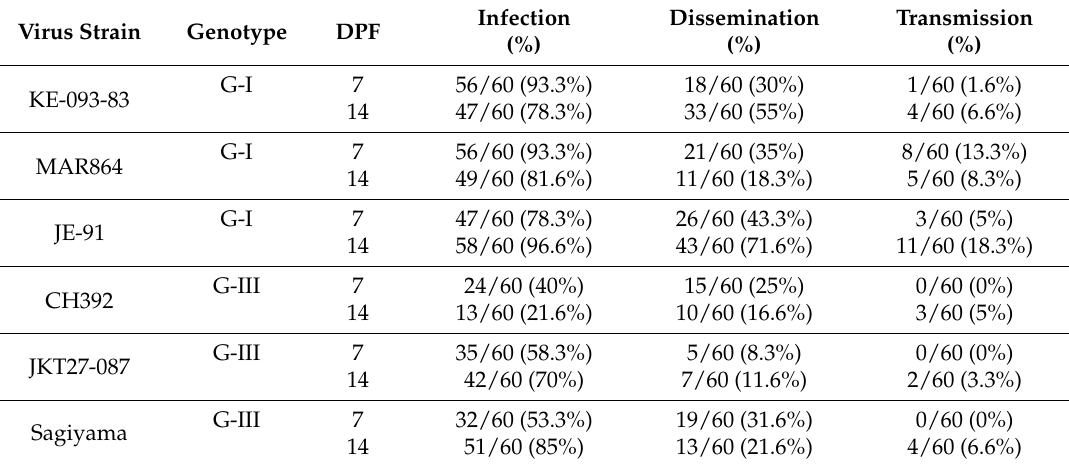
Table 4. Rates of infection, dissemination, transmission at 7- and 14-days post-feeding infectious blood meal to